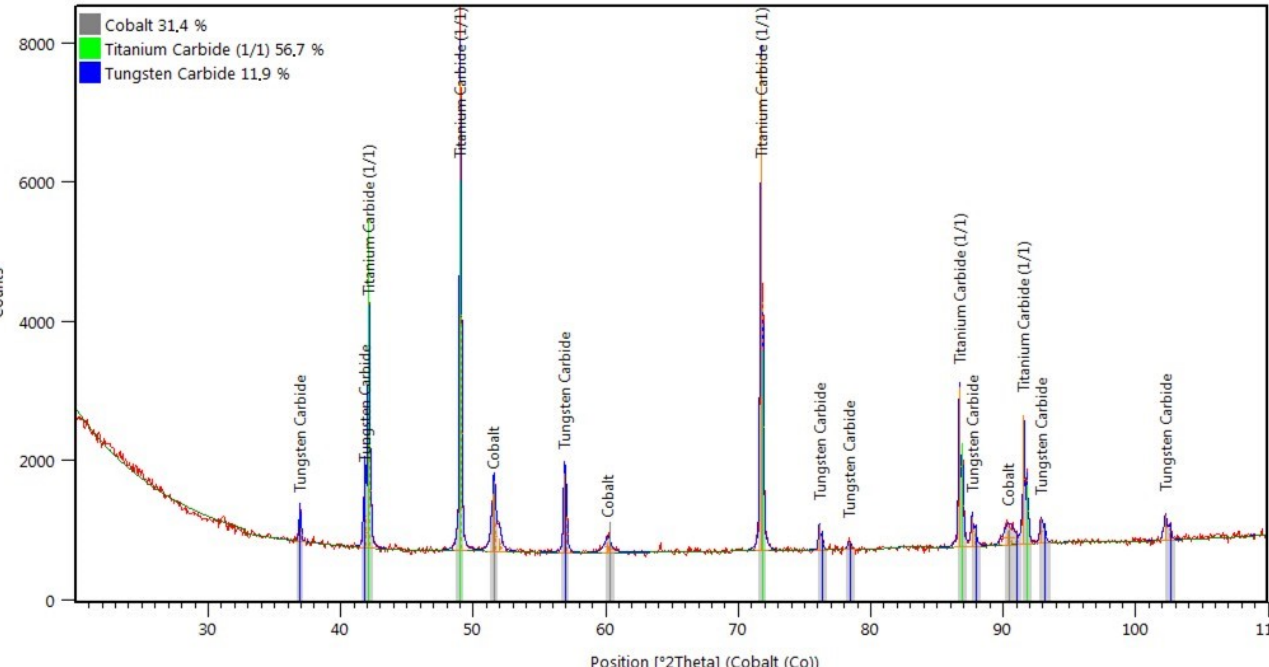
Figure 13. XRD pattern of the surface layer (PPTAW metal deposition method, Co3+TiC+PD-W composite powder) deposited on structural low-alloy steel AISI 4715 with the standard lines of identified crystalline phases. Table 4. Results of the X-ray qualitative phase analysis of the surface layer (PPTAW metal deposition method, Co3+TiC+PD-W composite powder) deposited on structural low-alloy steel AISI 4715. ICSD Card No.